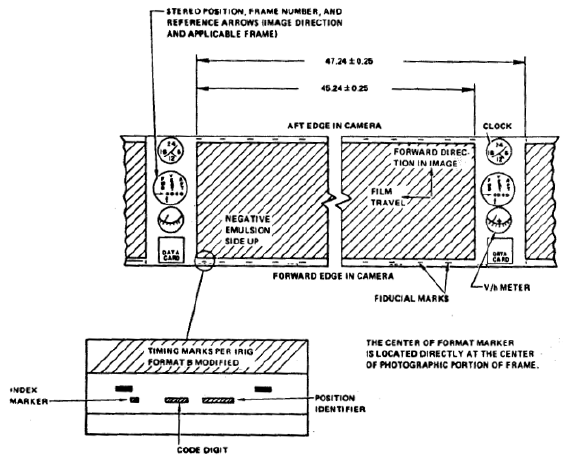
Figure 6: PC film format (from NASA, 1971b, Fig.